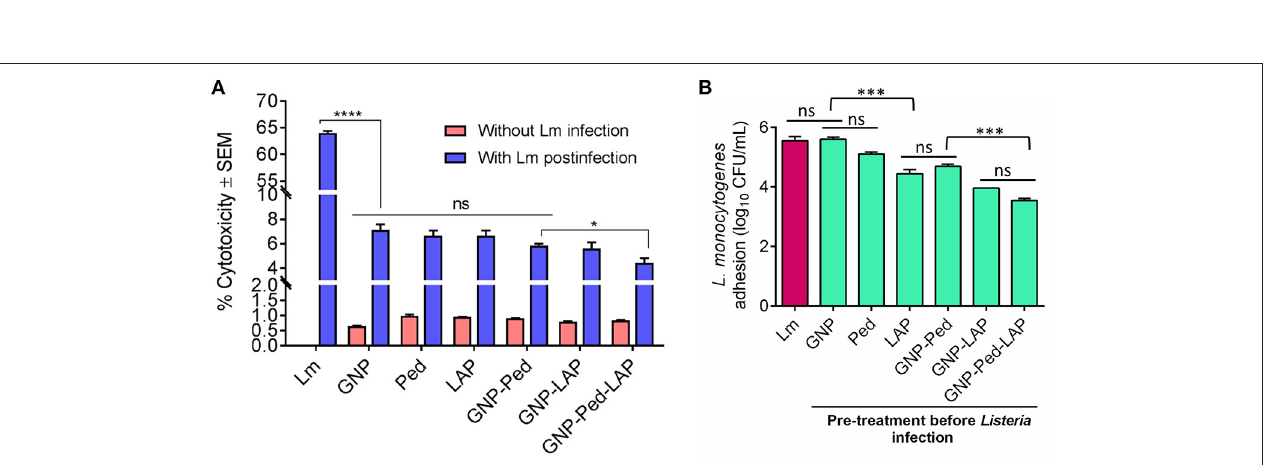
FIGURE 4 | In vitro assessment of cytotoxicity, preventive attributes, and anti-adhesion characteristics of gold nanocomposite with Caco-2 cell line. (A) Cytotoxicity was calculated by measuring the amount of lactate dehydrogenase (LDH) release from Caco-2 cells upon treatment with GNP, Pediocin (Ped) and LAP, GNP-Pediocin, GNP-LAP, GNP-Pediocin-LAP with or without L. monocytogenes infection. (B) Assessment of anti-adhesion attributes of GNP, and gold nanocomposites used in the cytotoxicity assay. Treatment of Caco-2 cells with L. monocytogenes (Lm) only was used a positive control. Data are average of three experiments analyzed in duplicate. **** P < 0.0001; *** P < 0.001; * P < 0.05; ns, no significance.